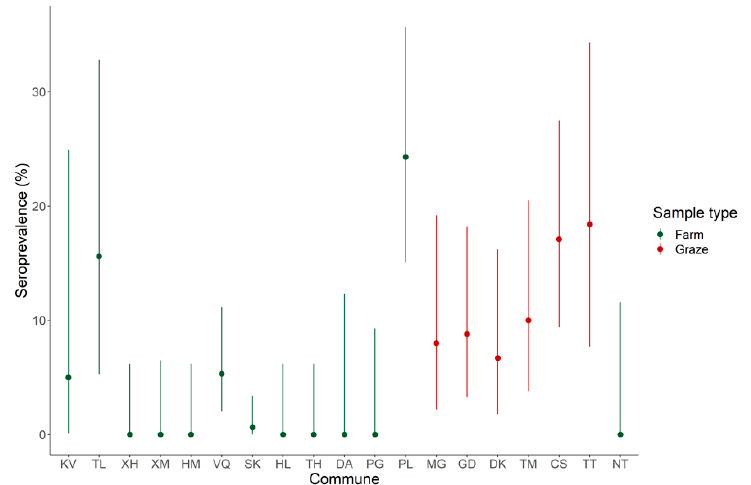
Figure 5. Seroprevalence in grazed versus farmed swine sampled in Vietnam analyzed in this study was significantly different. Seroprevalence rates of grazed (red) and farmed (green) are shown by individual commune with the 95% confidence intervals. Order of communes matches Figure 1.